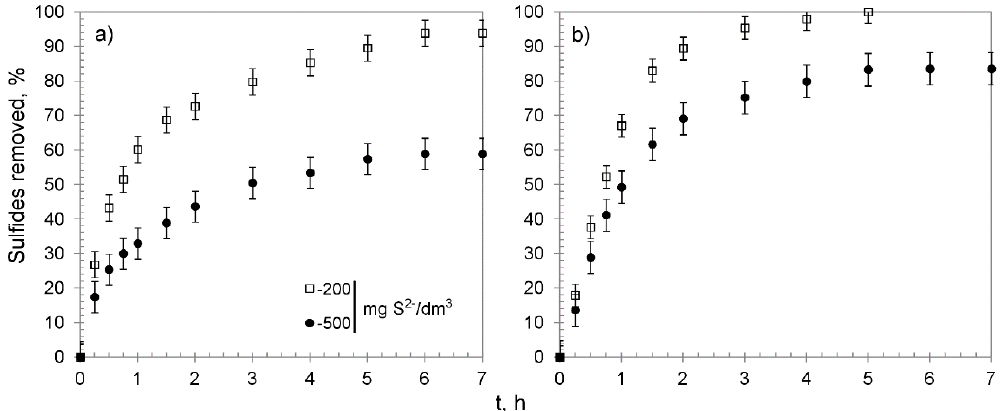
Figure 8. Sulfide removal effectiveness of hybrid materials versus time: ( a ) CWM1#MnO 2 /H + , ( b ) CWM3#MnO 2 /H + ; on average, n = 3.